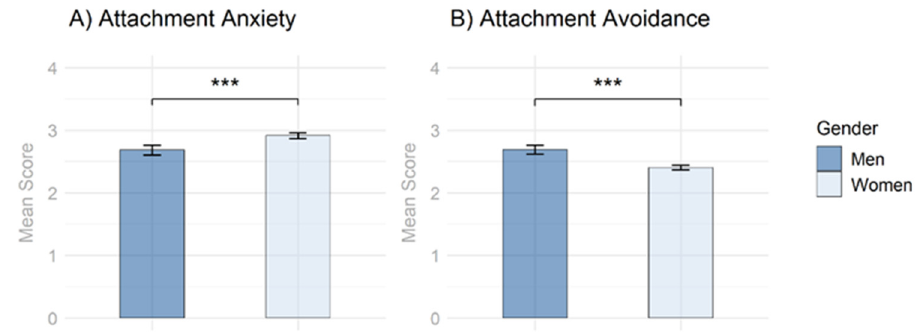
Figure 1. Gender Differences Regarding Attachment Dimensions. ( A ) Gender Differences Regarding Attachment Anxiety. ( B ) Gender Differences Regarding Attachment Avoidance. Note. p -values were adjusted for multiple testing using the Holm–Bonferroni method. *** = p < 0.001.